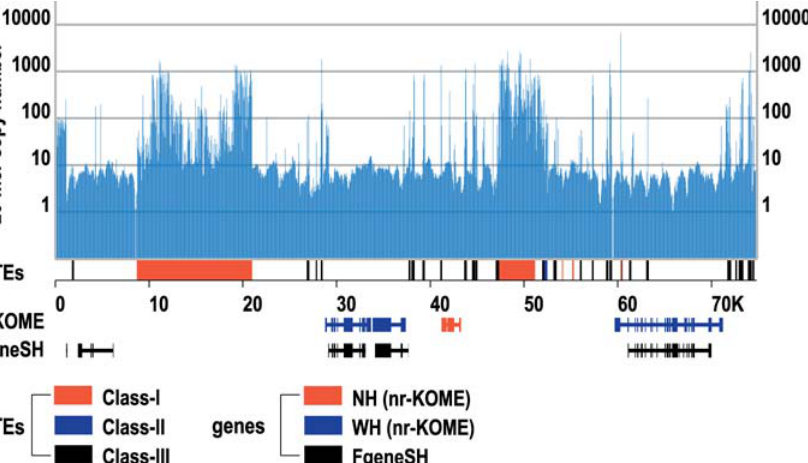
Figure 2. A Region on Beijing indica Chromosome 2, Showing Three Gene Islands Separated by Two Intergenic Repeat Clusters of High 20-mer Copy Number Transposable elements identified by RepeatMasker are classified based on the nomenclature of Table S2. Depicted genes include both nr-KOME cDNAs and FGENESH predictions. DOI: